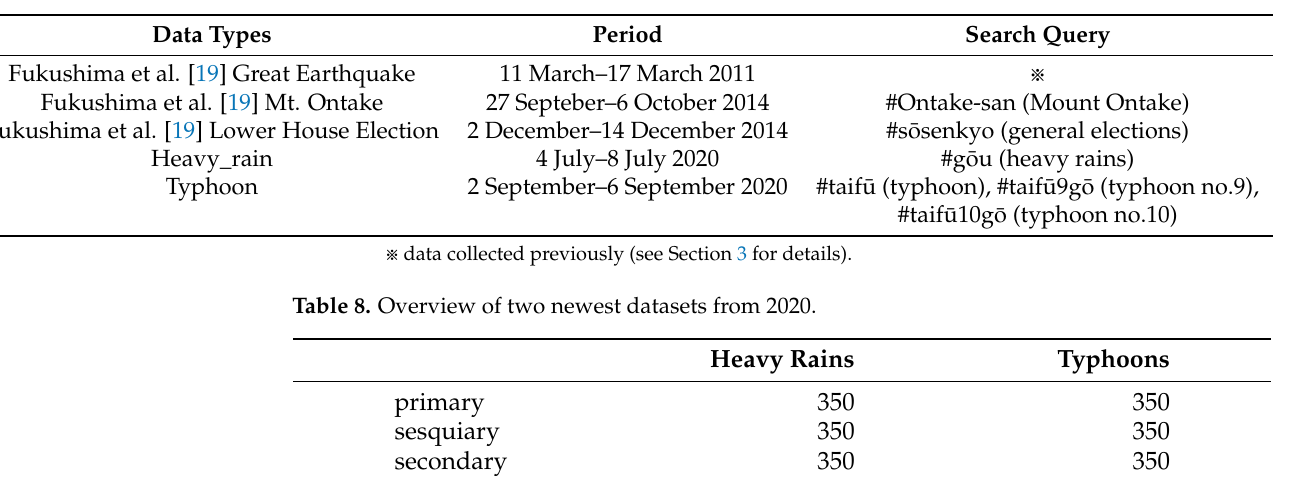
Table 7. Overview of periods from when the datasets were collected.